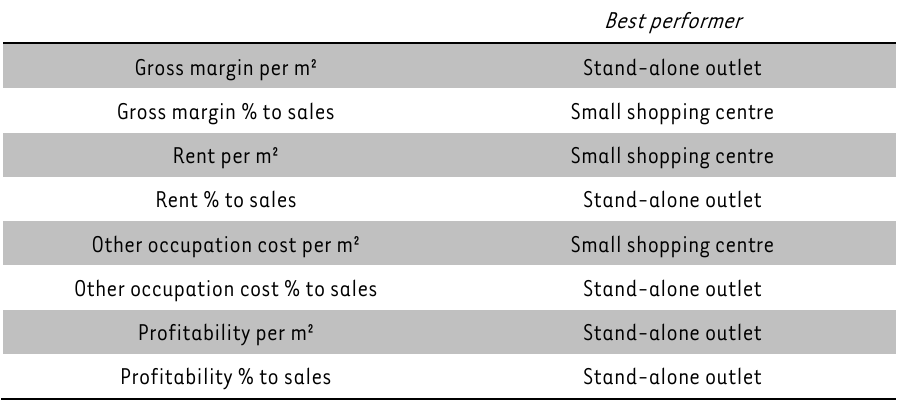
TABLE 13: Summary of results by performance